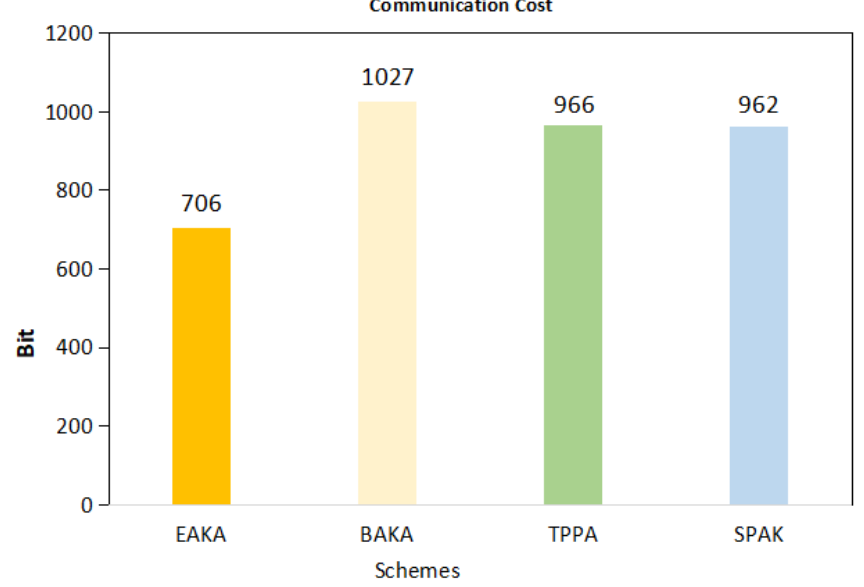
Figure 7. Authentication delay of each scheme under different attack frequency.